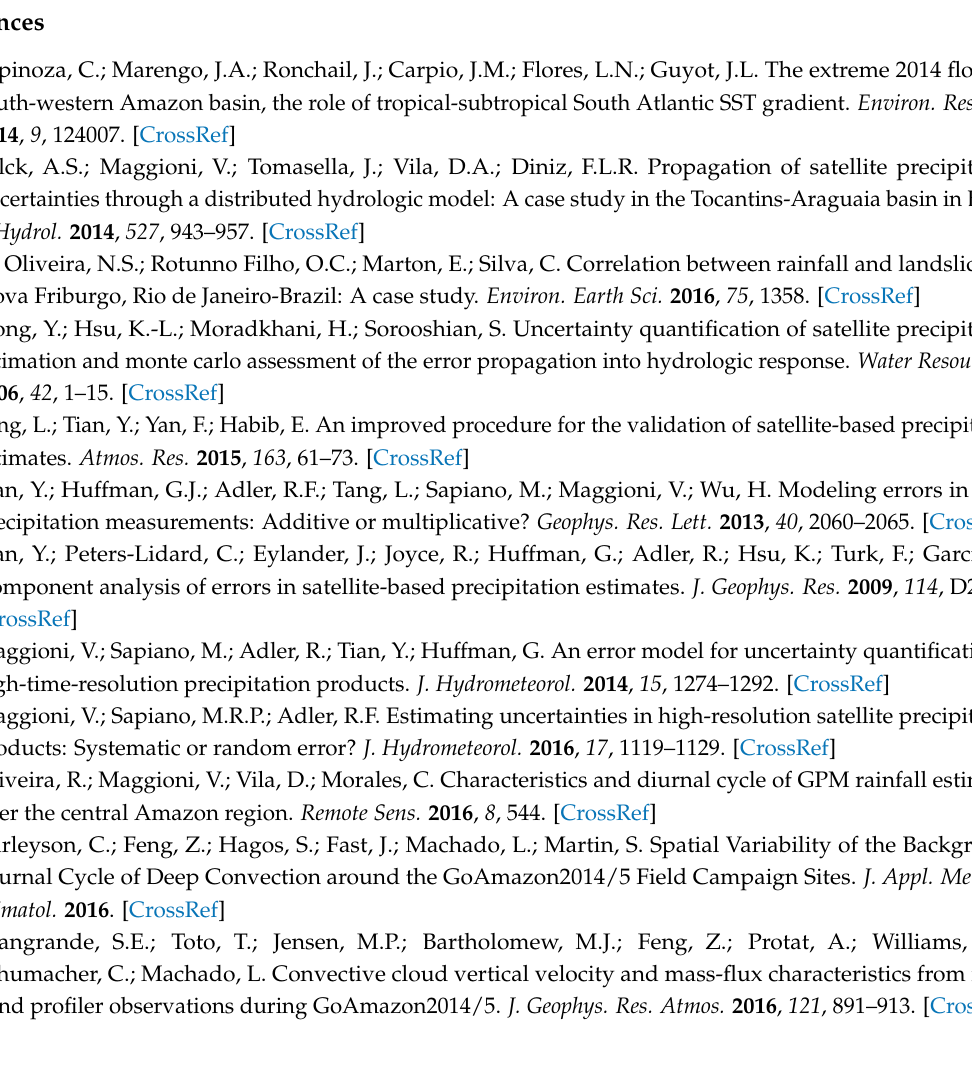
Figure S1. Probability of false alarm (P10) (upper panels) and probability of hit (P11) (lower panels) for a minimum threshold of 0.2 mm · h − 1 over land–river (green), over river only (red), and over land only (blue), during the dry (left panels) and wet (right panels) seasons. Figure S2. Distributions of correct no-precipitation detection errors (Case 0) for the 0.2 mm · h − 1 threshold over land–river (a), over river only (b), and over land only (c), during the dry (red) and wet (blue) seasons (calibration period). Bars indicate the observed PDF, dotted lines represent the simulated PDF, and dashed lines show the PDF differences (simulated–observed). Figure S3. PDF from observations (bars) and simulated by the error model (black lines) and their differences (estimated minus observed probability densities) for the dry (in red) and wet (in blue) calibration periods and over land–river (a,d), over river only (b,e), and over land only (c,f). Examples for threshold values of satellite rain rates of 2.5 and 10.0 mm · h − 1